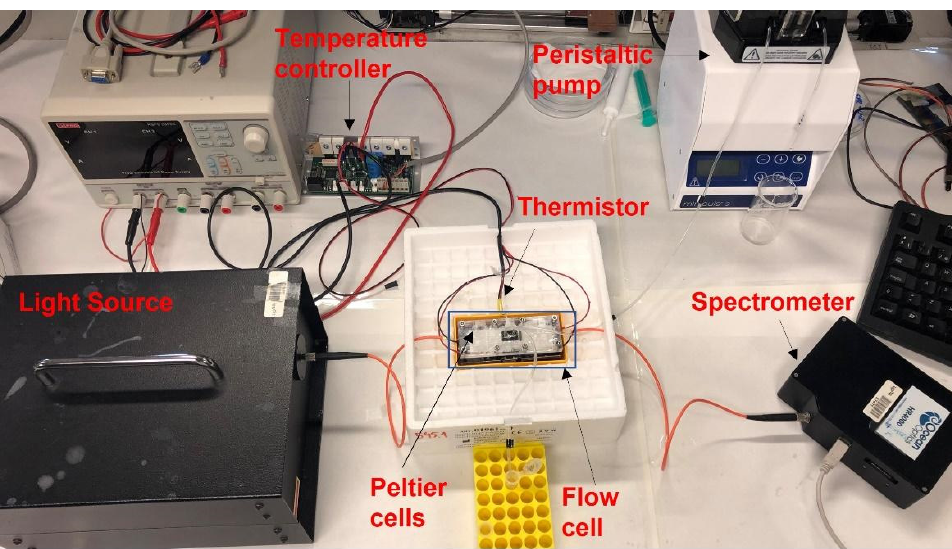
Figure 1. Picture of the experimental setup.